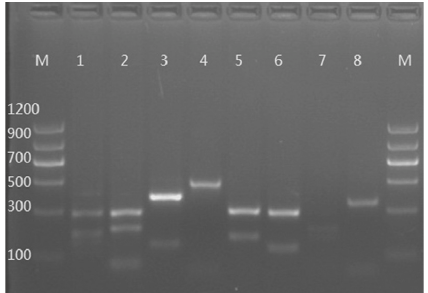
Figure 3: The PCR-RFLP result for eight target animals. Lane M represents DNA marker; lanes 1–8 represent goat, sheep, deer, buffalo, cattle, yak, pig, and camel, respectively.